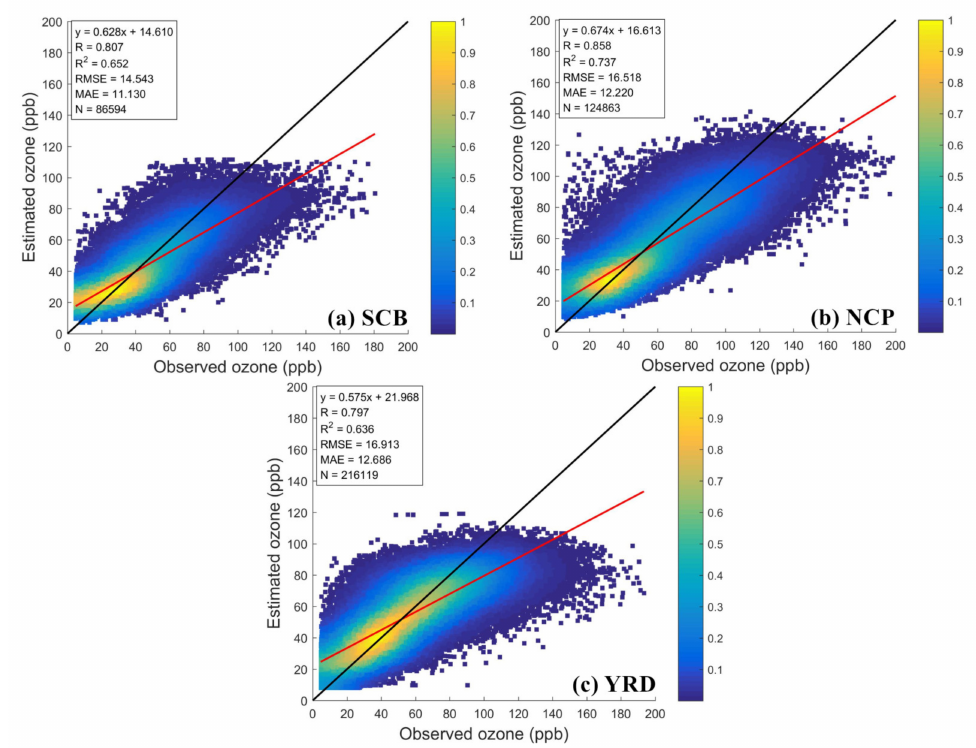
Figure 10. Scatter plots of surface ozone retrievals versus ozone observations in ( a ) SCB, ( b ) NCP, and ( c )